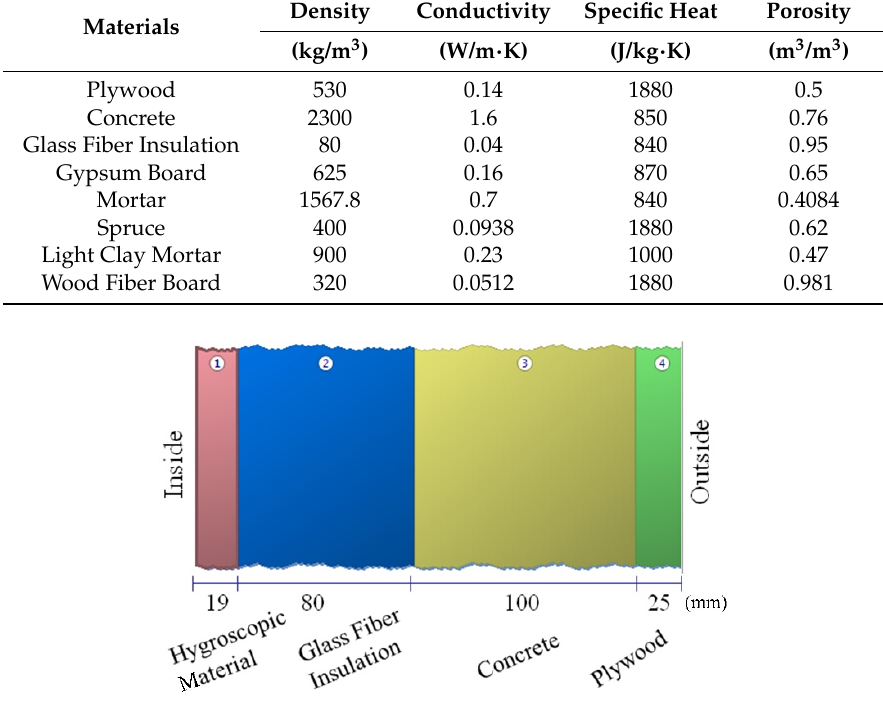
Figure 3. Wall construction. Figure 3. Wall